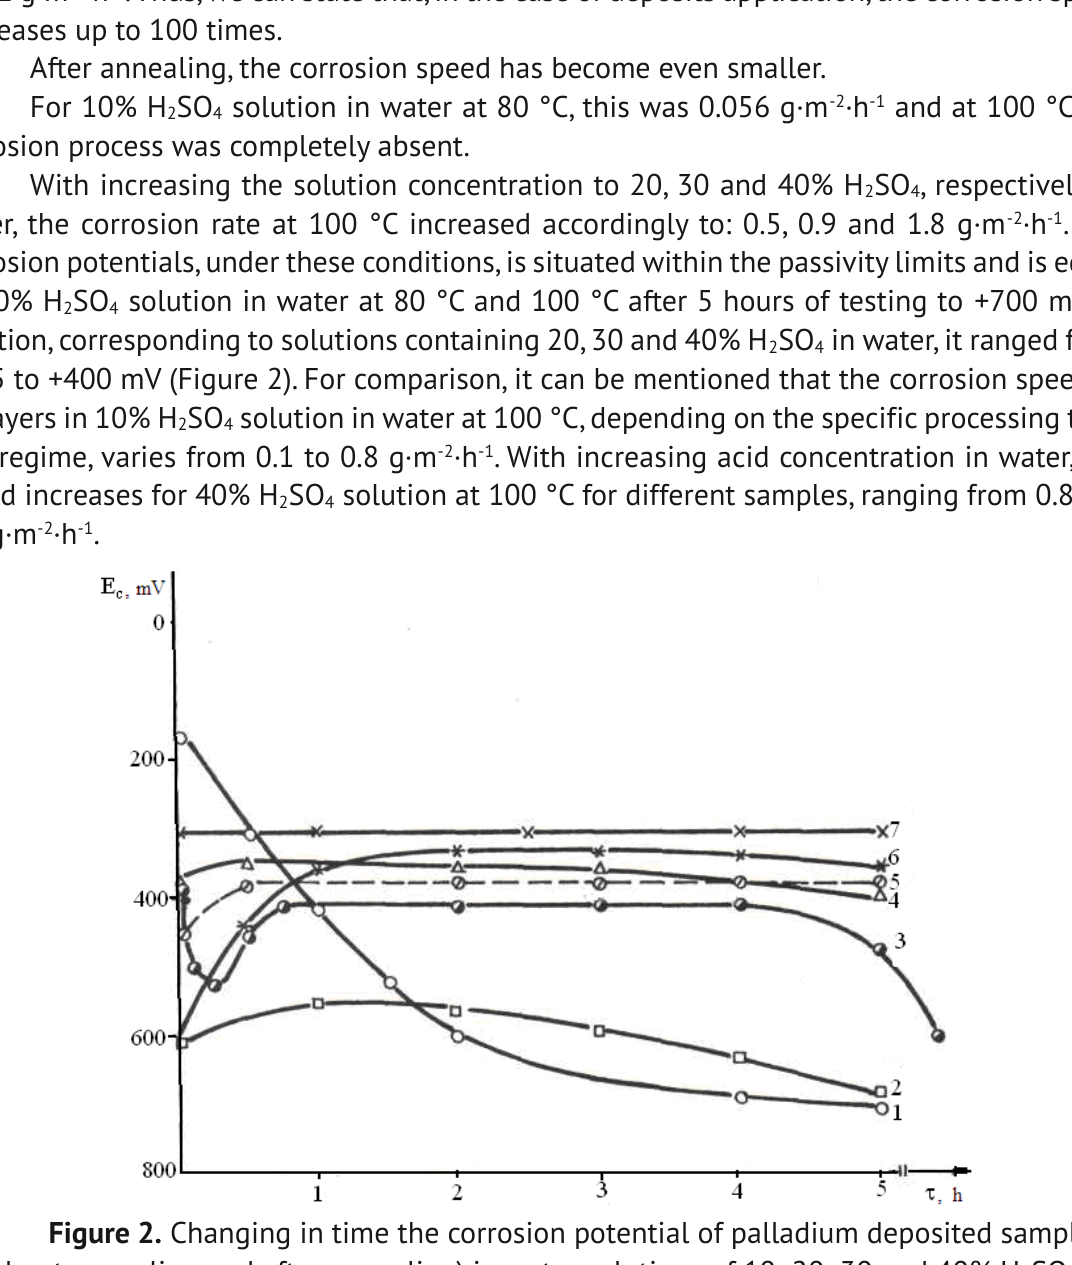
SO at 2 4 SO , 100 °C, with 2 4 SO , 100 °C, with 2 4